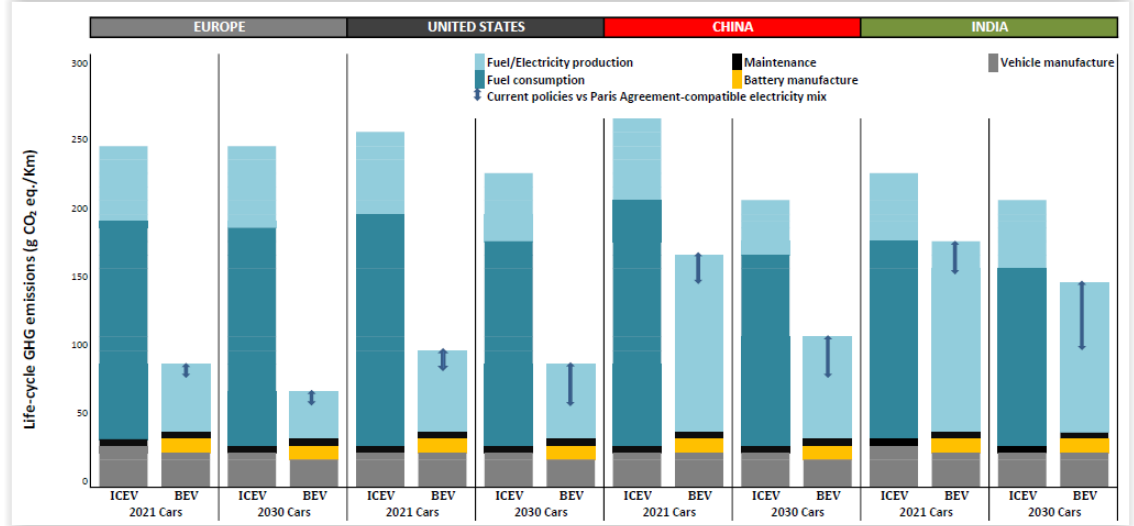
Figure 3. Life cycle analysis of medium-size gasoline internal combustion engine vehicle (ICEV) versus battery-powered engine vehicle (BEV) [redrawn from Ref. [80], open access].